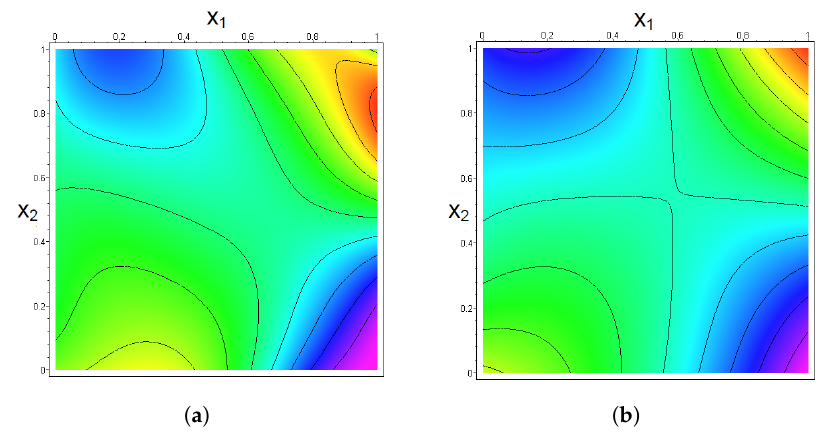
Figure 9. Contour plots for the adaptive Bernstein copula densities in Example 3. ( a ) Adaptive Bernstein